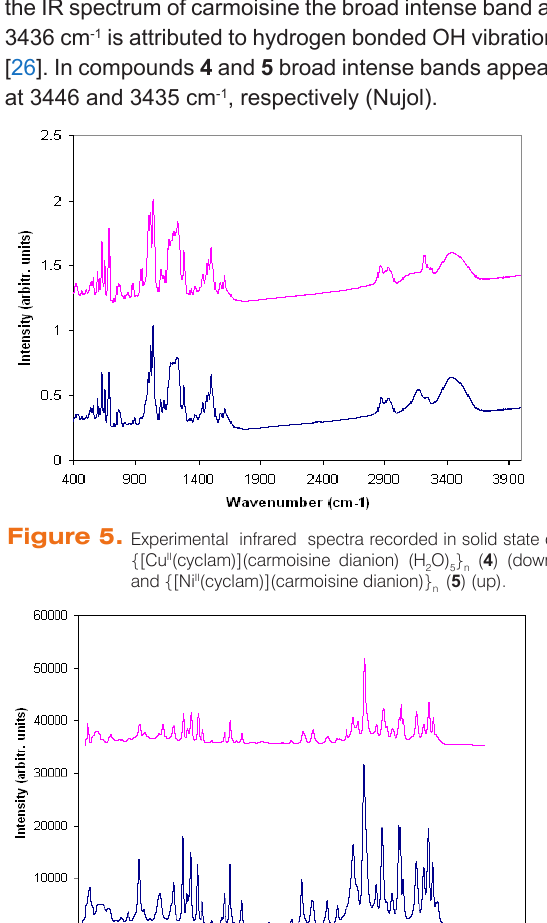
Figure 6. Experimental Raman spectra recorded in solid state of Table 1. Crystal data for coordination polymers 4 and 5 .